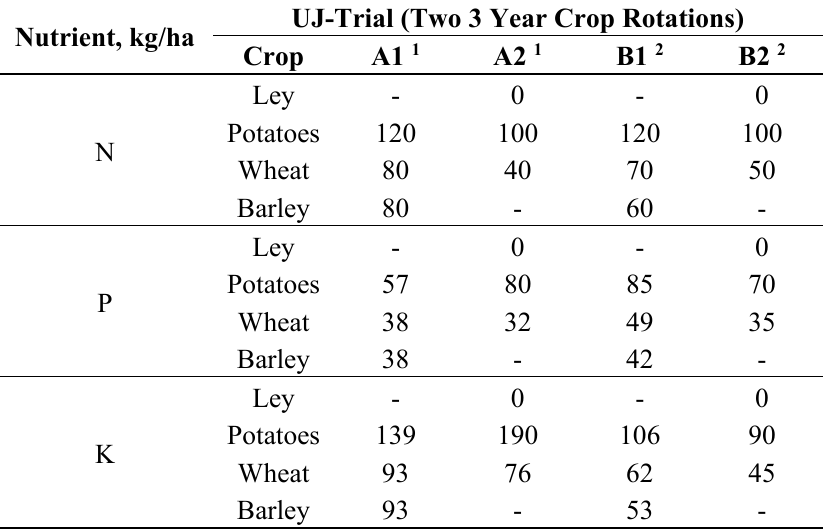
Table 2. Average supply of N, P and K in kg/ha and year, to different crops in the UJ-trial. Nutrient,